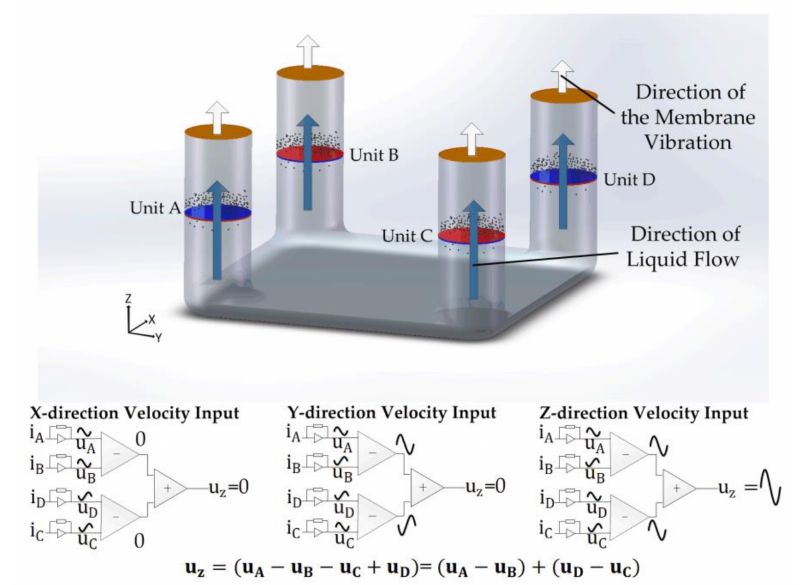
Figure 4. Sensing mechanism illustrations and schematics of fluid flowing mechanism in response to acceleration along z -axis. Blue arrows represent the direction of liquid flow due to the convection caused by the external vibration while white arrows represent the direction of the membrane vibration. i A , i B , i C , and i D represent the cathode currents in sensing unit A, B, C, D,